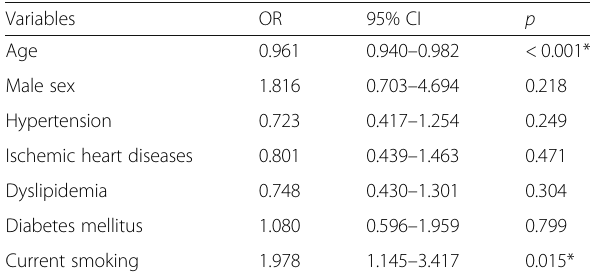
Table 2 Multivariable logistic regression analysis to identify variables associated with ACS occurring while driving